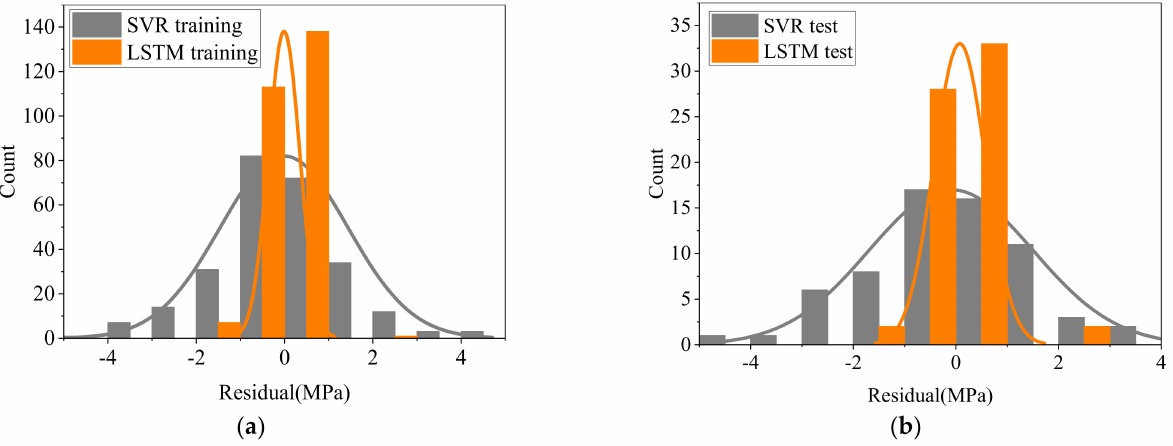
Figure 7. Residual error distribution of models: ( a ) training set; ( b ) test set.